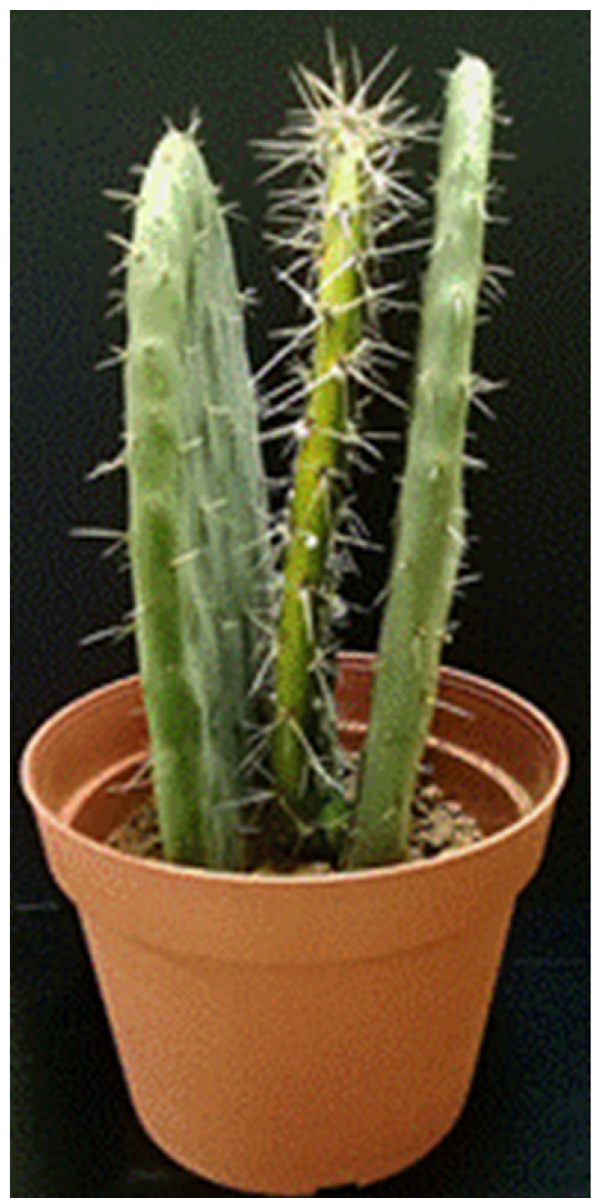
Figure 6. Reproduction model of the cochineal pest in a pot with adult cladodes near an infected cladode with active wild cochineal. Observe, in the center of the pot and between the two healthy cladodes, the infected